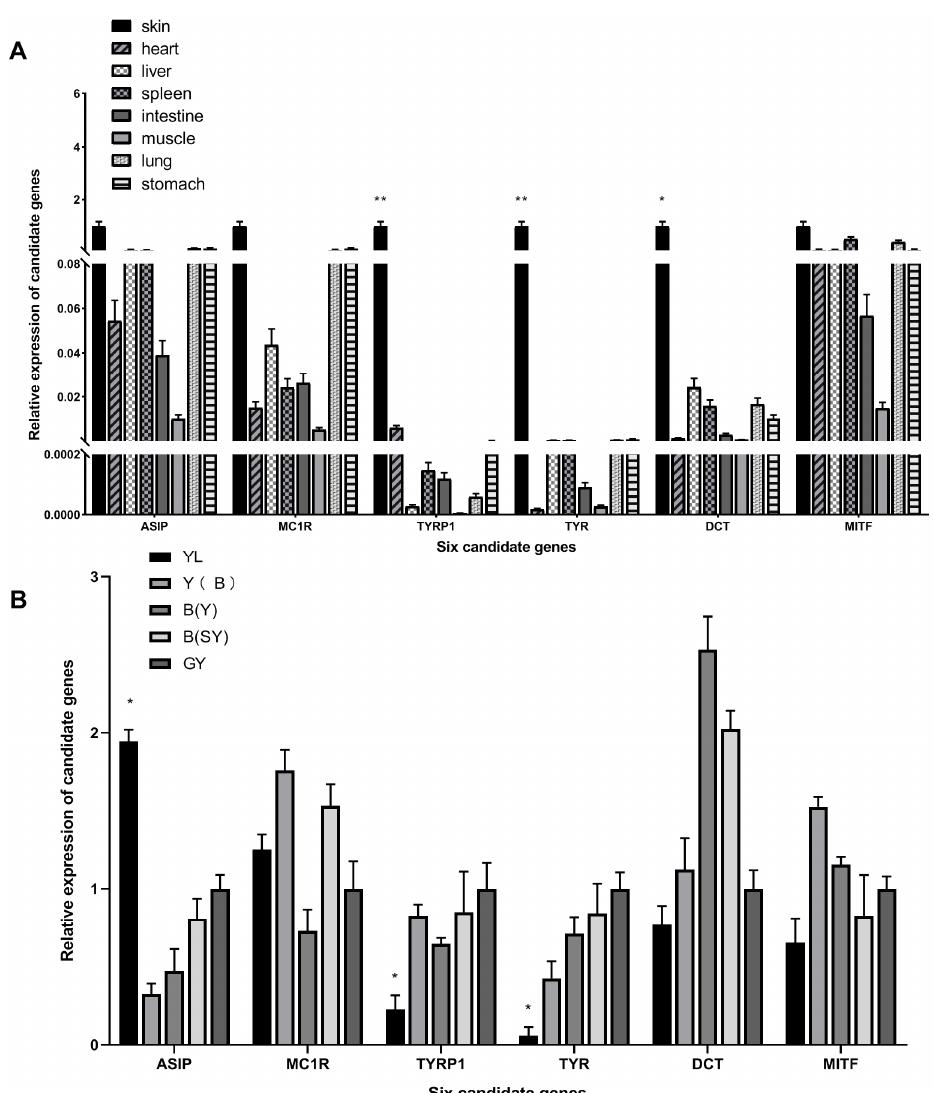
Figure 8. Expression of six genes related to pigmentation in different tissues and colors. ( A ) qPCR verification of the DEGs in eight different tissues of GY skin color individuals. ( B ) The expression of the selected DEGs in the skin of five skin colors. ( n = 3; * p < 0.05; ** p < 0.01).